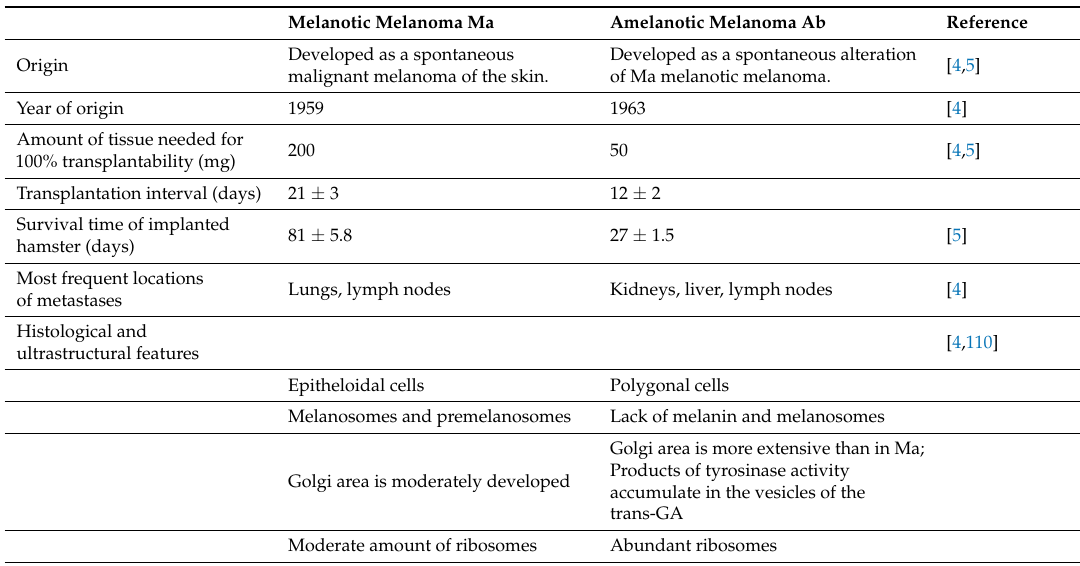
Table 1. Pathobiological parameters transplantable melanotic (Ma) and amelanotic (Ab) lines of Bomirski hamster melanoma